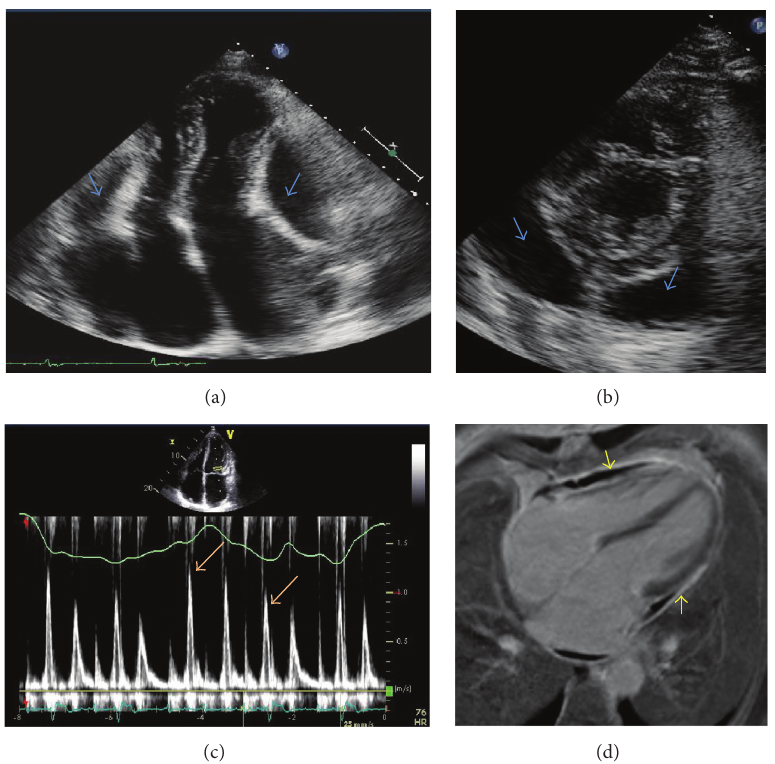
Figure 1: (a), (b) Transthoracic echocardiogram (apical (a) and parasternal short-axis (b)) before pericardiocentesis: two large, loculated pericardial effusions (blue arrows) are noted with significant indentations of the right and left ventricular free wall. (c) Pulsed-wave Doppler interrogation of mitral valve inflow on transthoracic echocardiogram: evidence of significant ( > 25%) reduction in mitral valve E velocity (orange arrows) consistent with constrictive physiology after pericardiocentesis. (d) Cardiac magnetic resonance imaging following gadolinium administration revealed diffuse pericardial thickening and delayed enhancement (yellow arrows) after